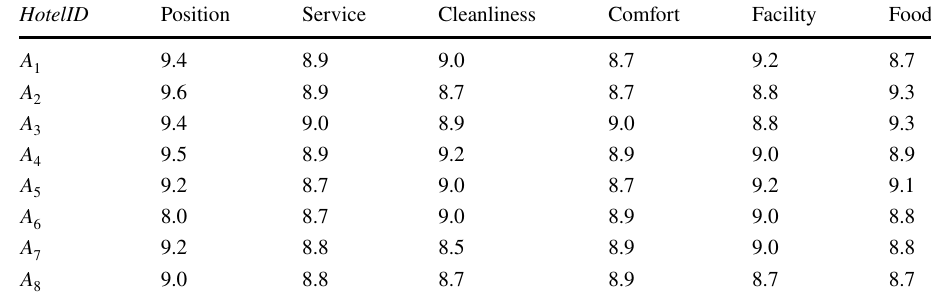
Table 11 Comprehensive Hotel